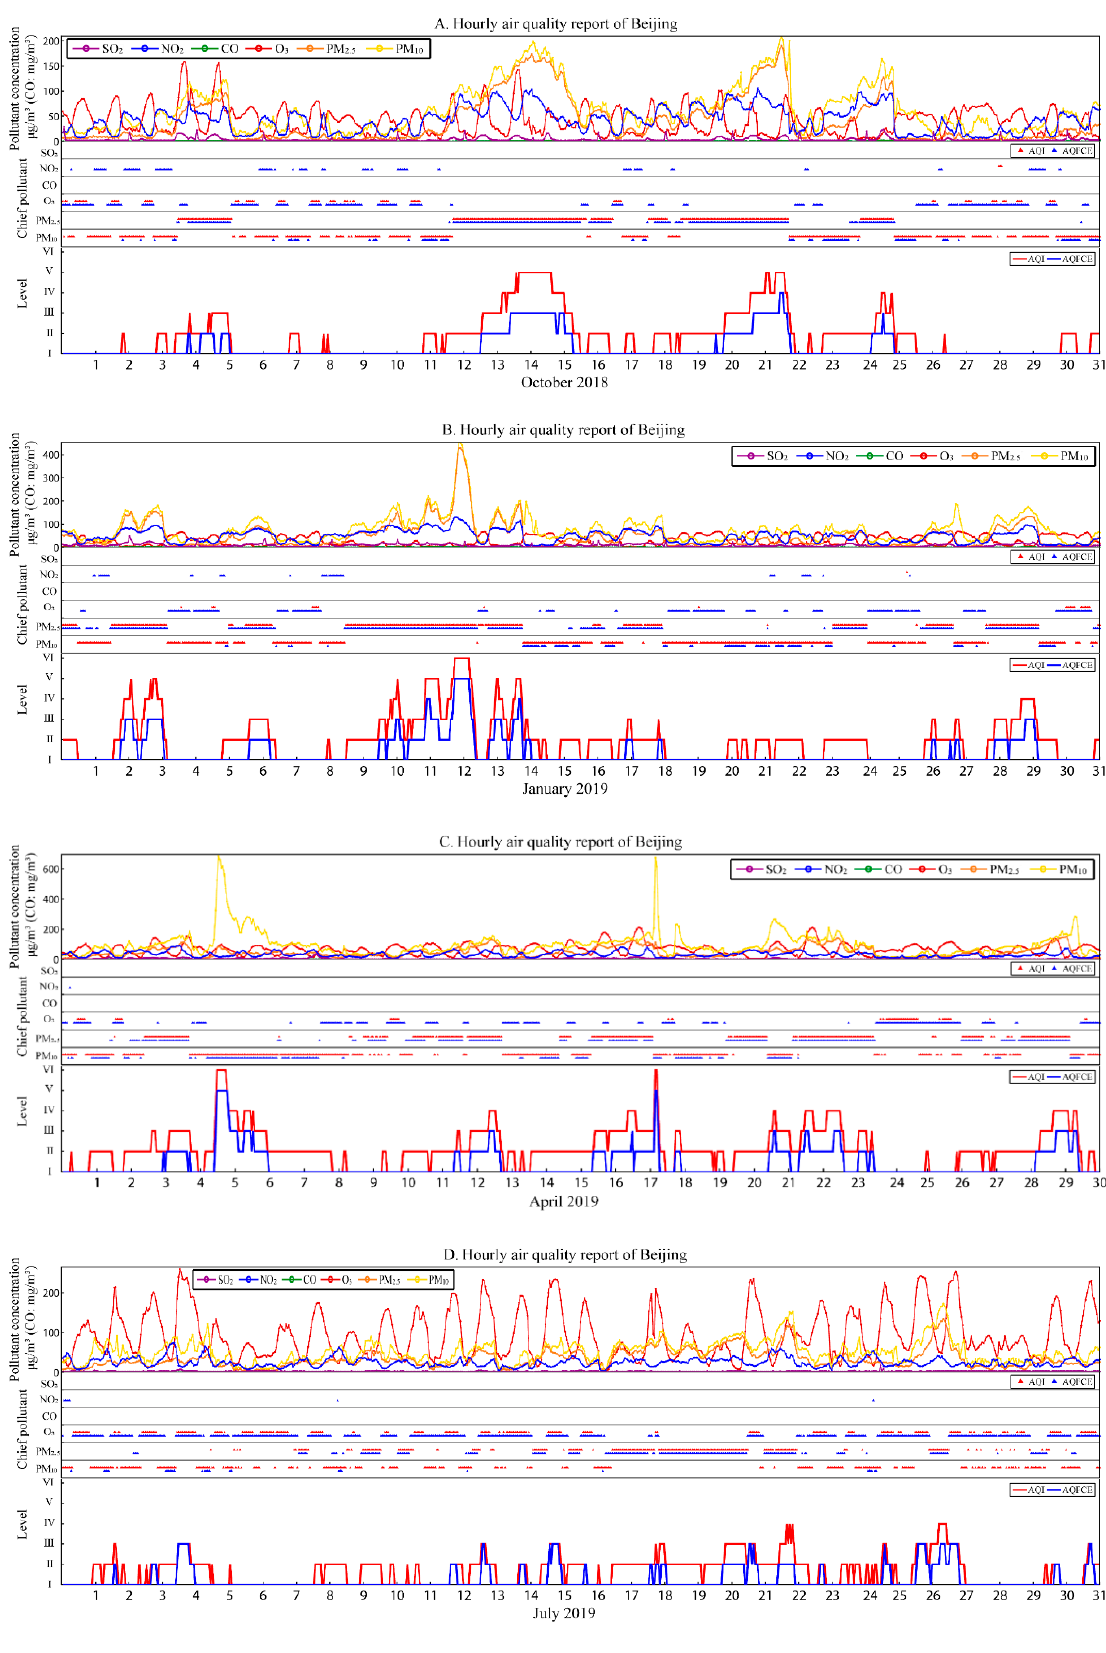
Figure 4. Hourly pollutant concentration variation and air quality evaluation result of chief pollutant and level of Beijing.